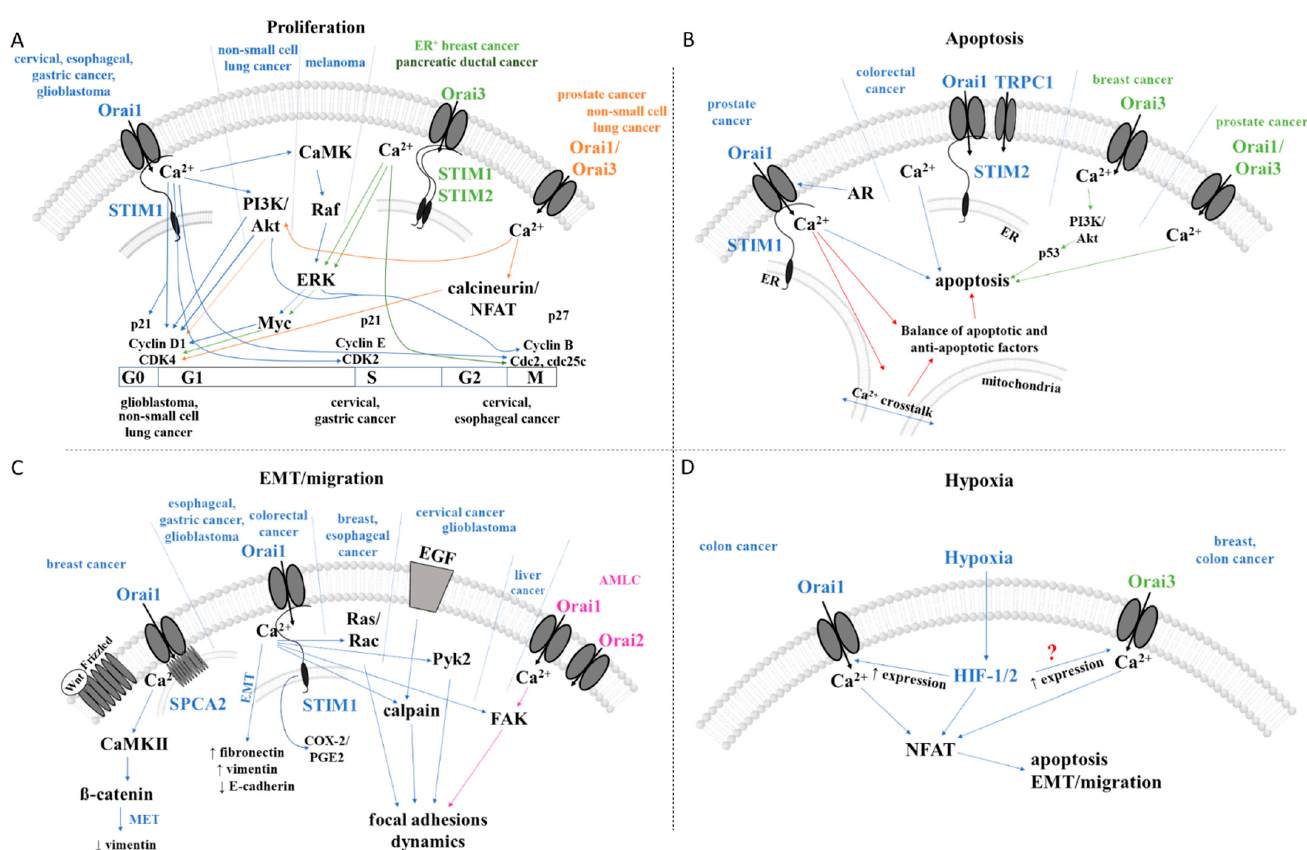
Figure 4. Cancer features and associated CRAC channel-dependent signaling pathways in different cancer types. The schematics summarize the current knowledge of signaling pathways controlling cancer features (proliferation ( A ), apoptosis ( B ), EMT/migration ( C ), and hypoxia ( D )) of the mentioned cancer types depending on CRAC channel components, TRP channels, or SPCA2. ? … signaling pathway is unknow. Colors indicate which cancer type correlates (arrow in corresponding color) which signaling pathway. Software used for all figure drawings: Procreate, Chemdraw (RRID:SCR_016768).